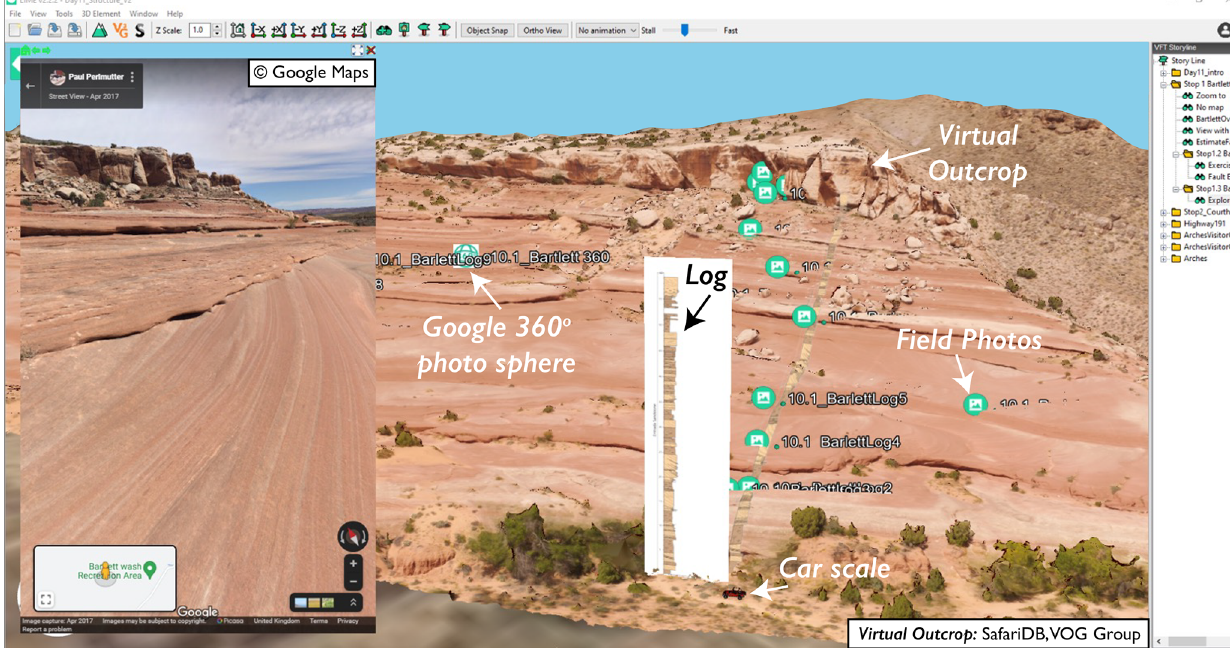
Figure 5. Bartlett Wash, Utah, USA. The task at this locality is to interpret the depositional environment and consider reservoir compart- mentalization. Virtual outcrop imported from SafariDB (2021; collected and processed by VOG Group) and viewed in LIME with additional material including logs, photos and 360 ◦ photo spheres (example inset ©Google